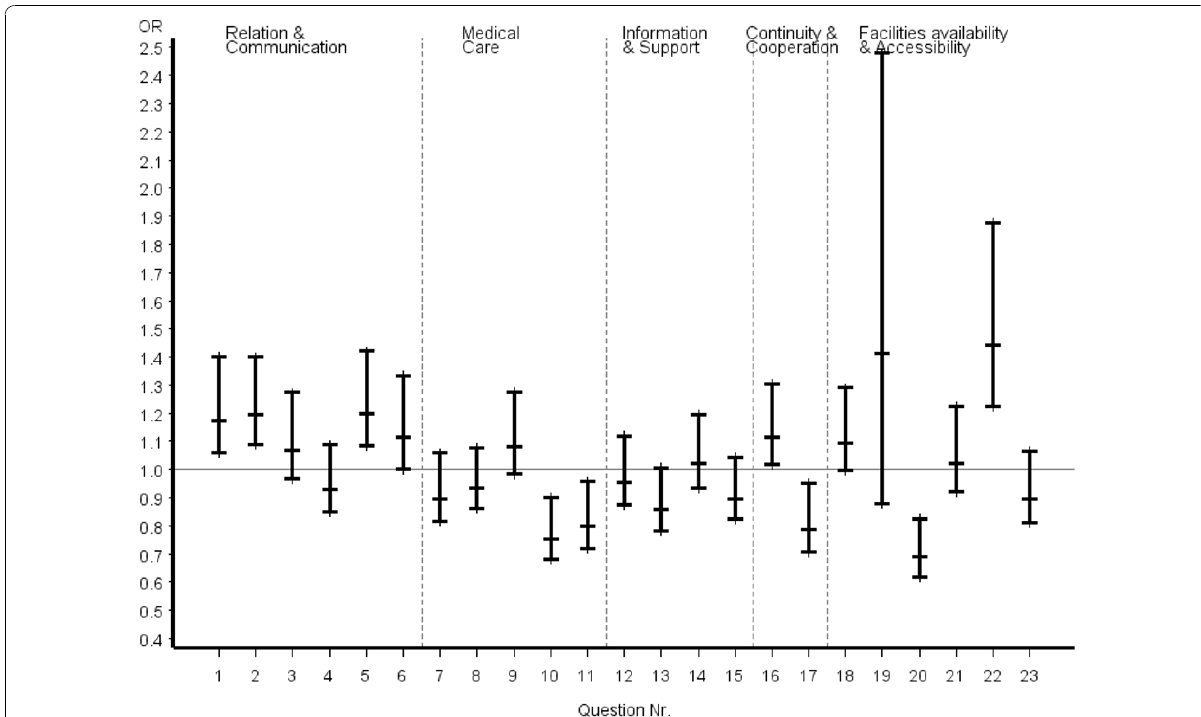
Figure 5 ..Europep questionnaire, odds ratios of most favourable answer option (certified CAM vs. COM) Stratified analysis of patients with non-chronic conditions . Errorbars denote 95% confidence intervals of odds ratios